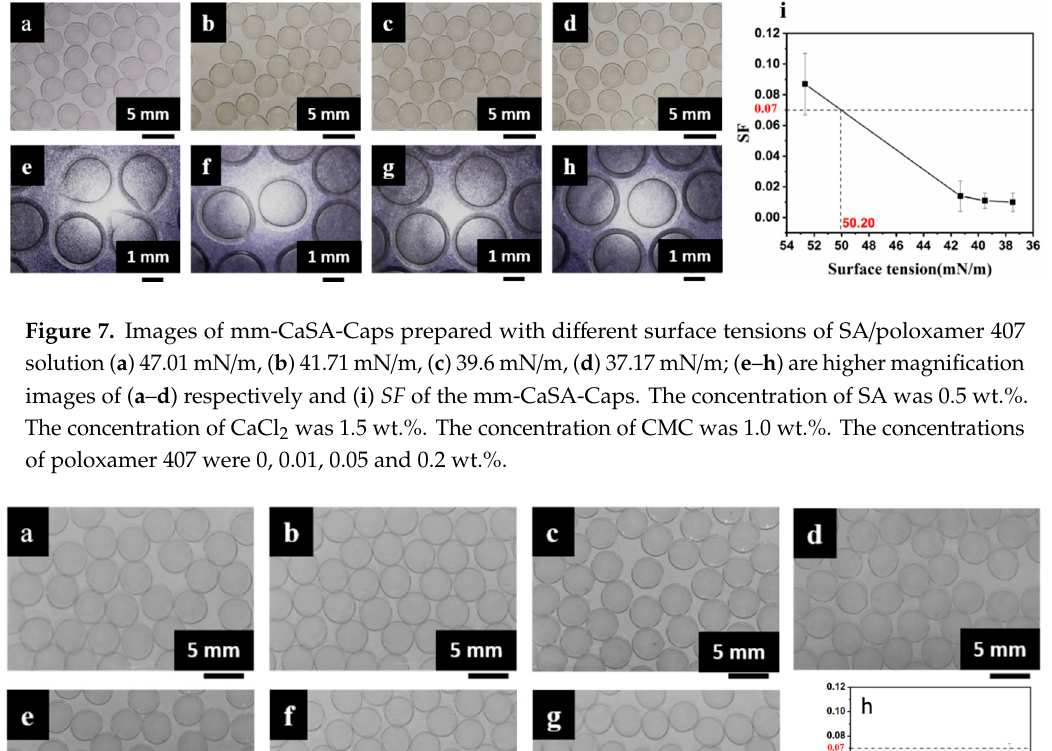
Figure 7. Images of mm-CaSA-Caps prepared with different surface tensions of SA/poloxamer 407 solution ( a ) 47.01 mN/m, ( b ) 41.71 mN/m, ( c ) 39.6 mN/m, ( d ) 37.17 mN/m; ( e )–( h ) are higher magnification images of ( a )–( d ) respectively and ( i ) SF of the mm-CaSA-Caps. The concentration of SA was 0.5 wt.%. The concentration of CaCl 2 was 1.5 wt.%. The concentration of CMC was 1.0 wt.%.